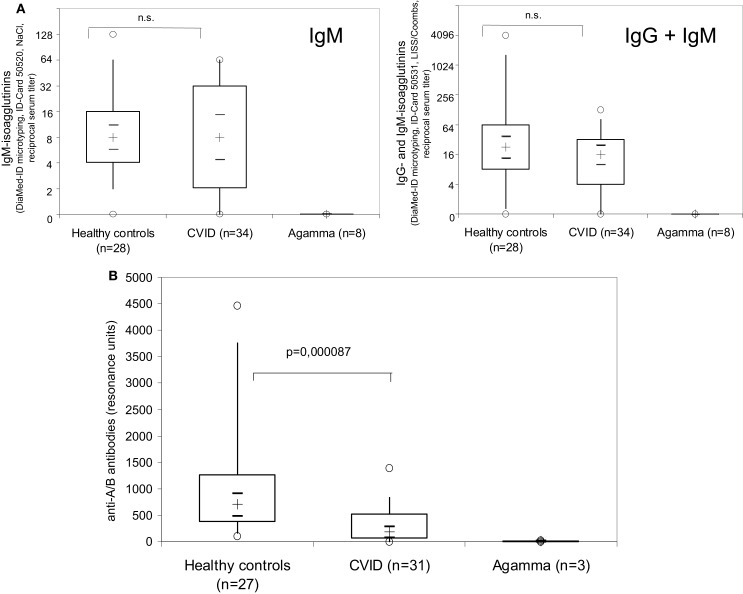
Examination of anti-A/B antibodies in CVID patients, patients with XLA and healthy controls using the Diamed-ID Micro Typing System with the ID-Card 50520 (NaCl) to measure IgM isoagglutinins [(A), left panel] or with the ID-Card 50531 (LISS/Coombs containing polyspecific AHG serum) to determine IgG- in addition to IgM-isoagglutinins [(A), right panel] and surface plasmon resonance (SPR) technology without identification of the antibody isotype using synthetic blood group A/B trisaccharides coupled to the CM-5 Biacore® chip by amine binding (B). Reciprocal serum isoagglutinin titers [(A), left panel, IgM isoagglutinins; (A), right panel, IgG and IgM isoagglutinins] and SPR resonance units (B) are depicted using box plot diagrams, the median of the study group is represented by a cross, the interquartile range (IQR) is represented by the box, 5- and 95-percentile values are represented by the whiskers, and minimum and maximum values are represented by circles. The 95% confidence interval for the median calculated according to McGill et al. (21) is indicated by horizontal bars. The non-parametric Mann–Whitney U-test (two-sided P value) was used for statistical comparison between patients and healthy controls.